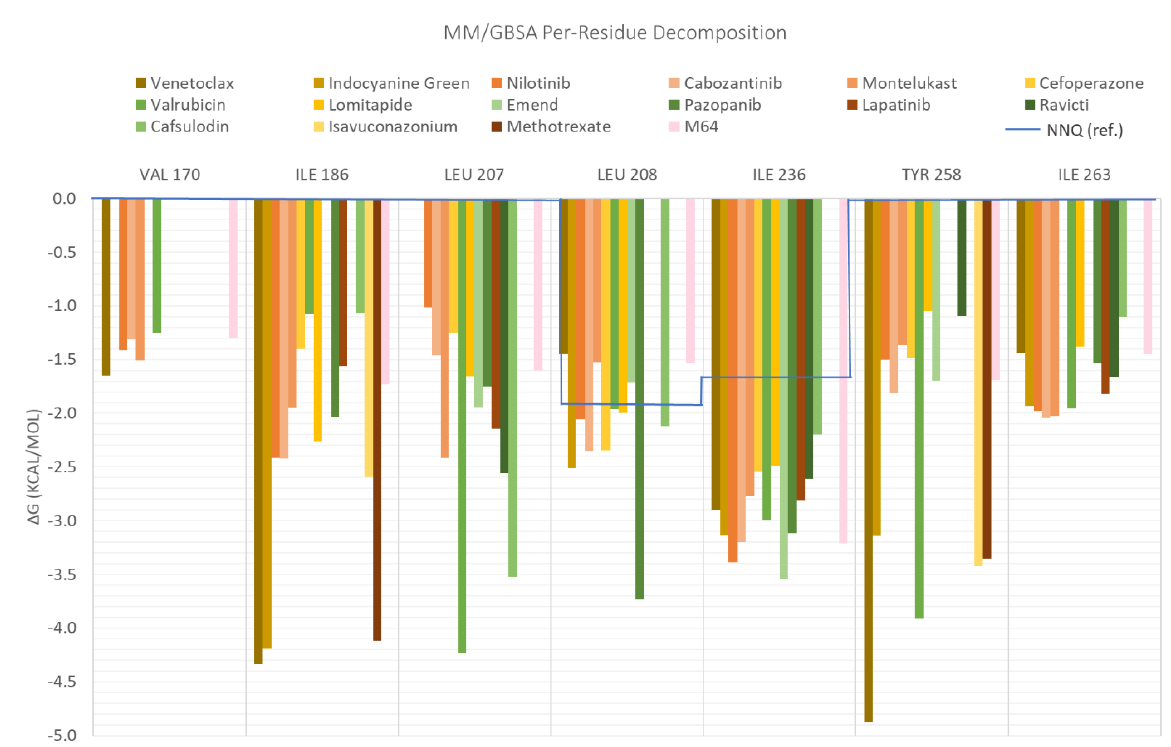
Figure 6. Per-residue decomposition of the free-energy calculations using MM/GBSA for the fifteenth selected FDA compounds.